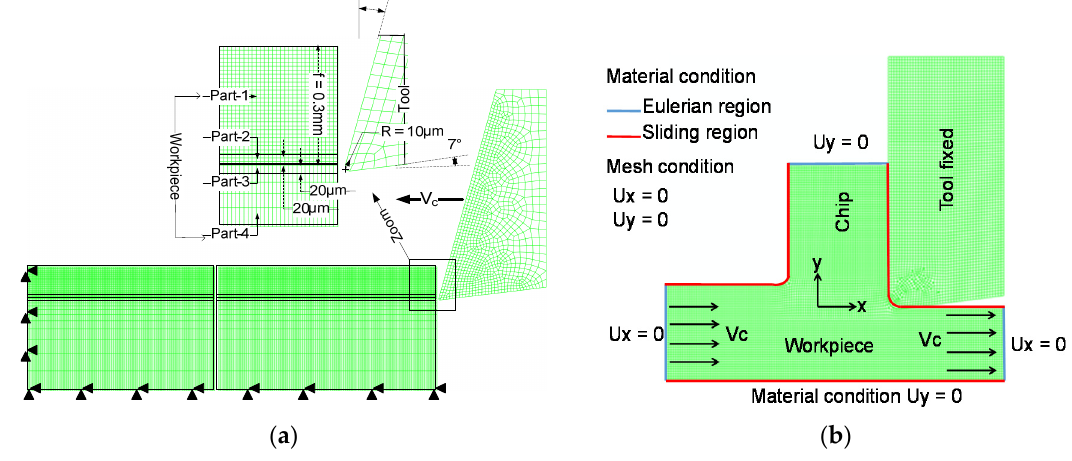
Figure 6. Illustration of ( a ) 2D LAG ‐ FE (lagrangian finite element) and ( b ) ALE ‐ FE (arbitrary lagrangian ‐ eulerian finite element) models of the orthogonal cutting.